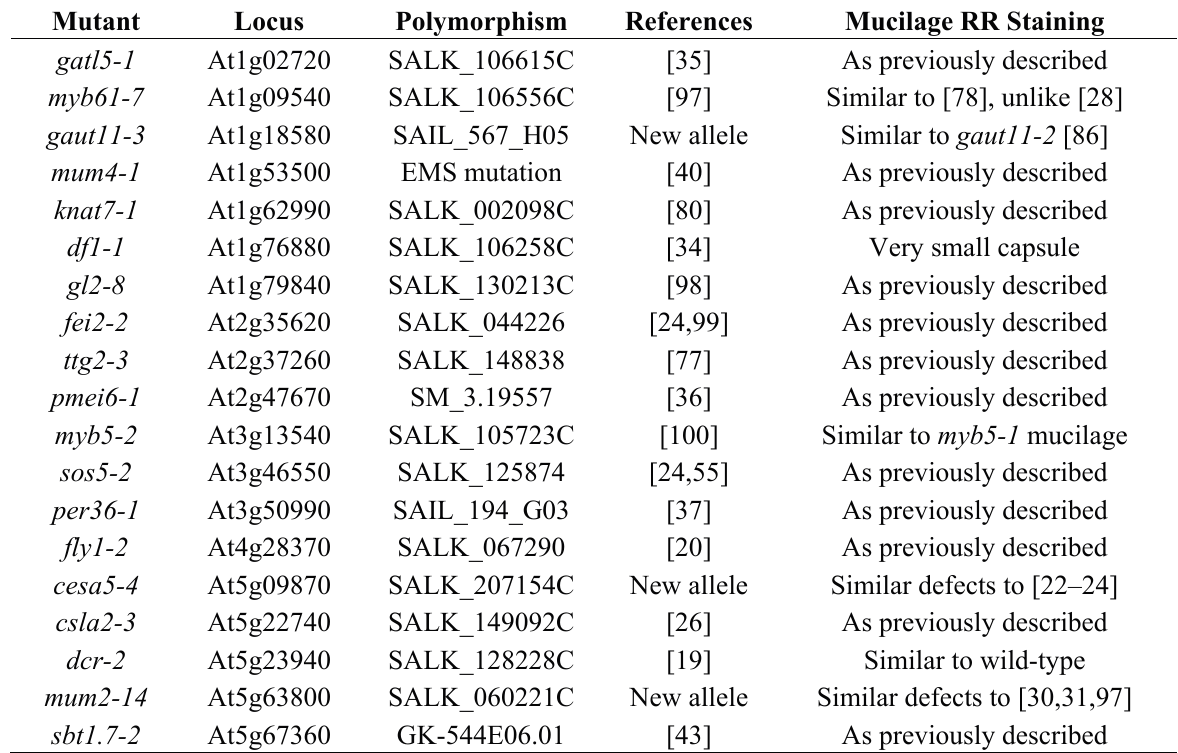
Table 1. A summary of mutants re-assessed for mucilage RR staining